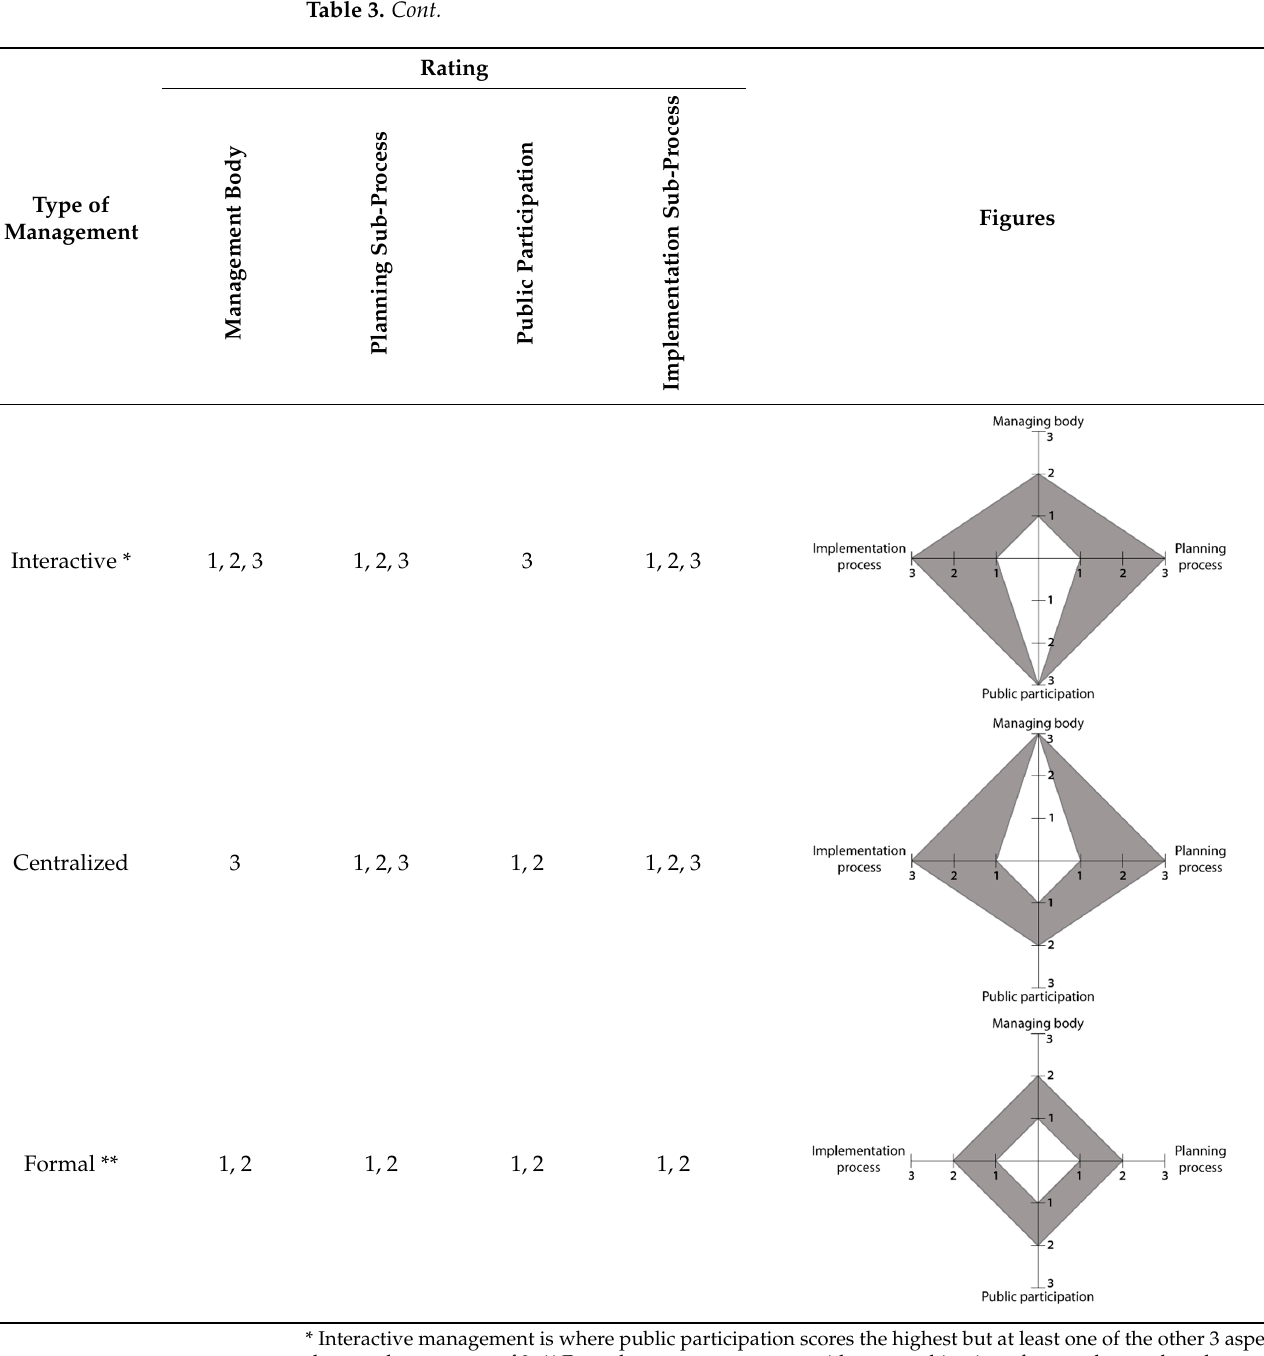
( c ) Figure 2. ( a ) Evaluation of the management of Brijuni National Park; ( b ) Evaluation of the manage- ment of Telaš ć ica Nature Park; ( c ) Evaluation of the management of Pakleni Islands Significant Landscape. Pakleni Islands scored 2.9 for the management body, 2 for the planning stage, 2.1 for public participation, and 2 for the implementation stage. With these results, the park man- agement model falls into the centralized scenario (Figure 2c). Figure 3 shows the assessment for each of the indicators analyzed in Brijuni National Park, Telaš ć ica Nature Park, and Pakleni Islands Significant Landscape. Table 4 shows some details on the assessment of each of the